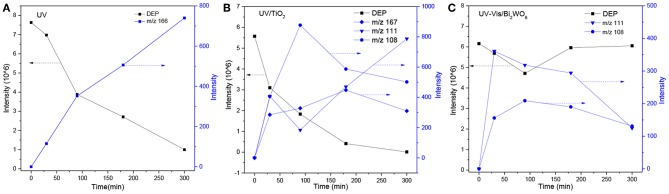
Time-dependent evolution profiles of DEP and its byproducts in different systems (A: UV; B: UV/TiO2; C: UV-Vis/Bi2WO6).